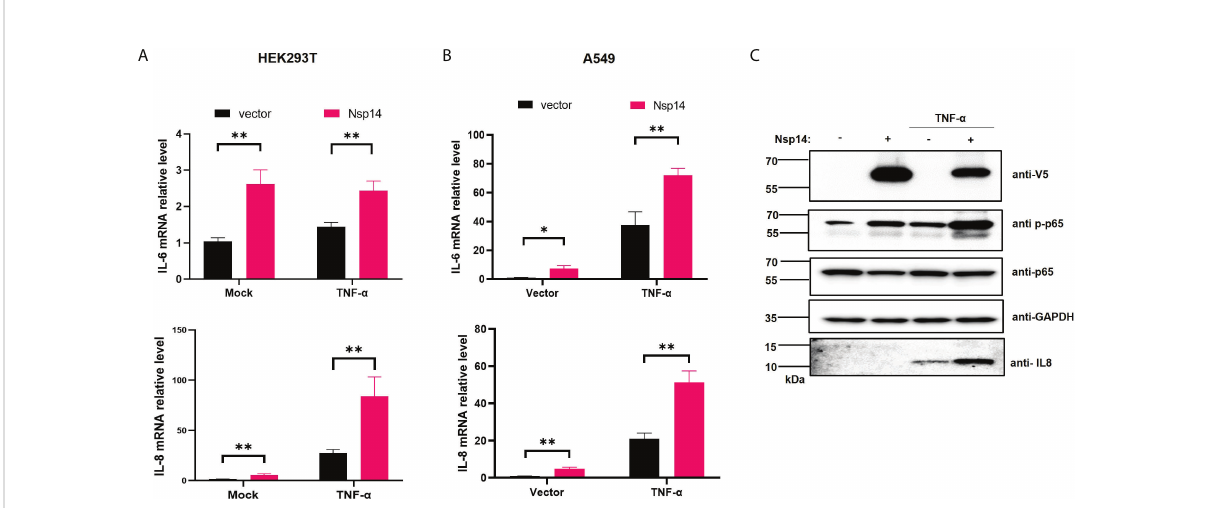
FIGURE 2 SARS-CoV-2 Nsp14 increases IL-6/8 expression. (A) HEK293T cells were transfected with V5-FLAG-Nsp14 or empty vector were un-treated or treated with TNF- a for 24h. The mRNA level of IL-6 and IL-8 in these cells was measured and normalized to the untreated, empty vector- transfected group. (B) A549 cells were treated similarly as in (A) and analyzed for IL-6 and IL-8 mRNA expression. (C) Protein level of Nsp14, phosphate, and total NF- k B p65, as well as IL-8, in A549 cells transfected with or without FLAG-V5-Nsp14 +/- TNF- a was measured by immunoblotting. Results were calculated from at least 3 independent experiments and presented as mean +/- standard error of the mean (SEM). (* p<0.05; ** p<0.01; by unpaired Student ’ s